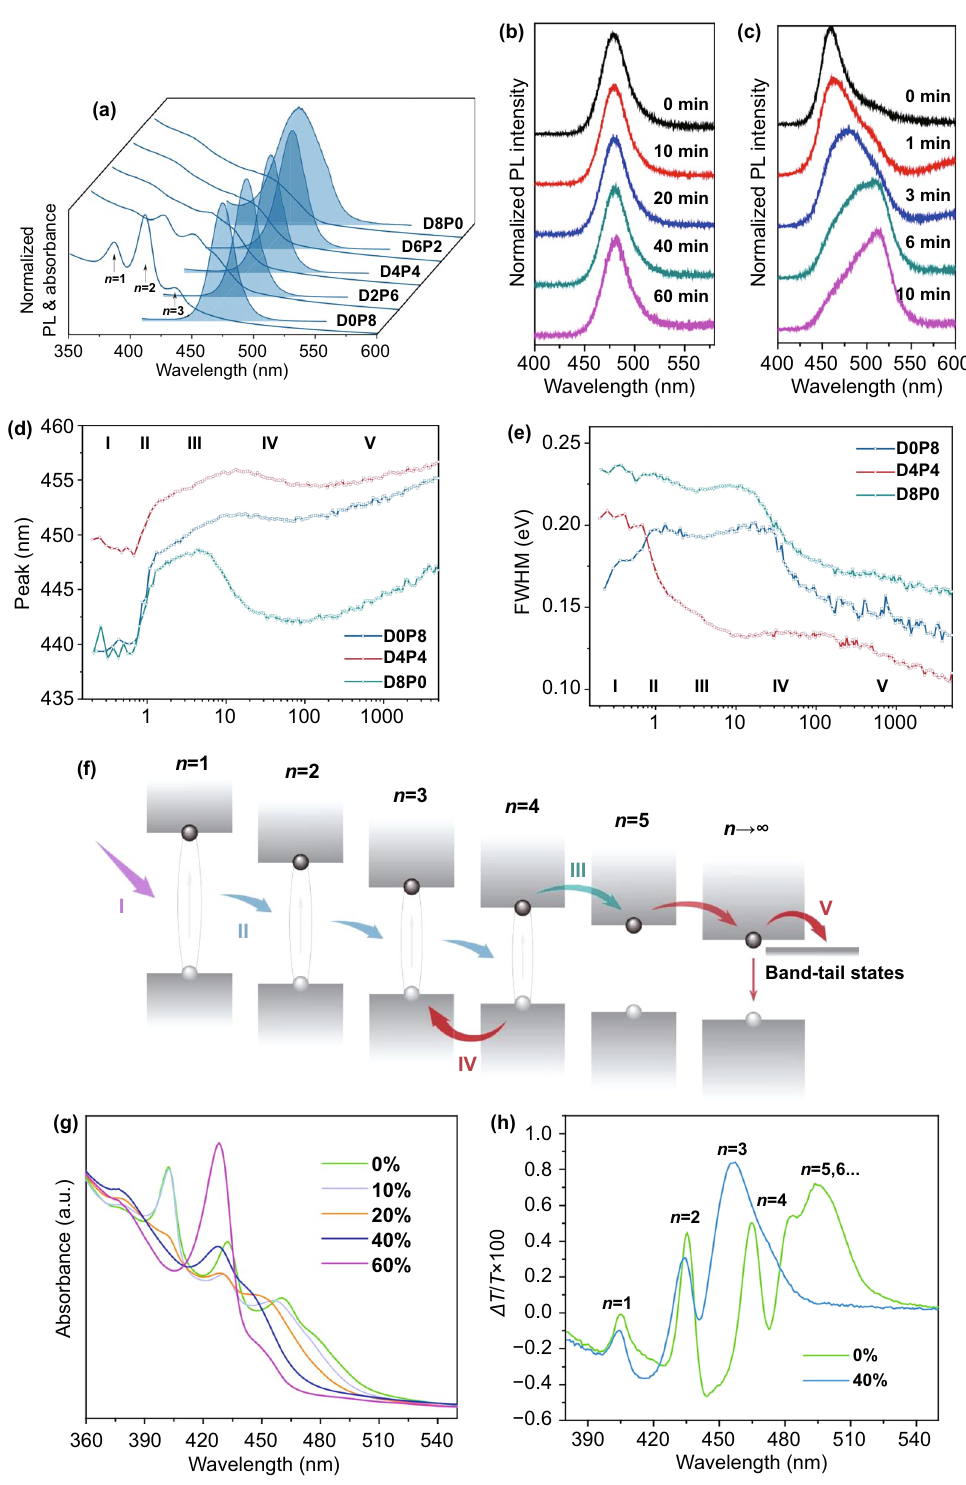
Fig. 10 a Steady-state PL and absorption spectra. PL spectra of b PEA 2 A 1.5 Pb 2.5 Br 8.5 with 40% IPABr and c MAPbCl 1.5 Br 1.5 under continuous laser radiation for different exposure times. The evolution of d peak and e FWHM are extracted from the broad bleach peak (425–470 nm) of samples D0P8, D4P4 and D8P0. f Sche- matic diagram of carrier behaviors after excitation. I, carrier formation; II, exciton transfer; III, charge transfer; IV, reverse charge transfer; V, continuous charge transfer and recombination. g Absorption spectra of perovskite PEA 2 A 1.5 Pb 2.5 Br 8.5 with 0 − 60% IPABr. h TA spectra of PEA 2 A 1.5 Pb 2.5 Br 8.5 with 0 and 40%